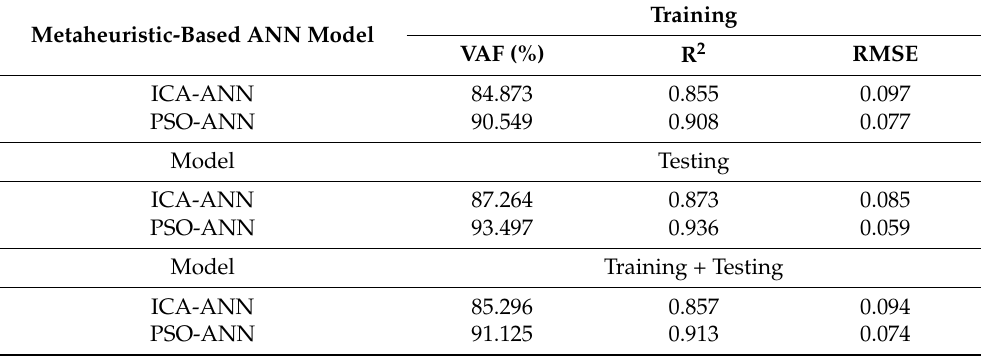
Table 3. Results of training, testing, and all data samples in predicting the bearing capacity of the SCFST columns.